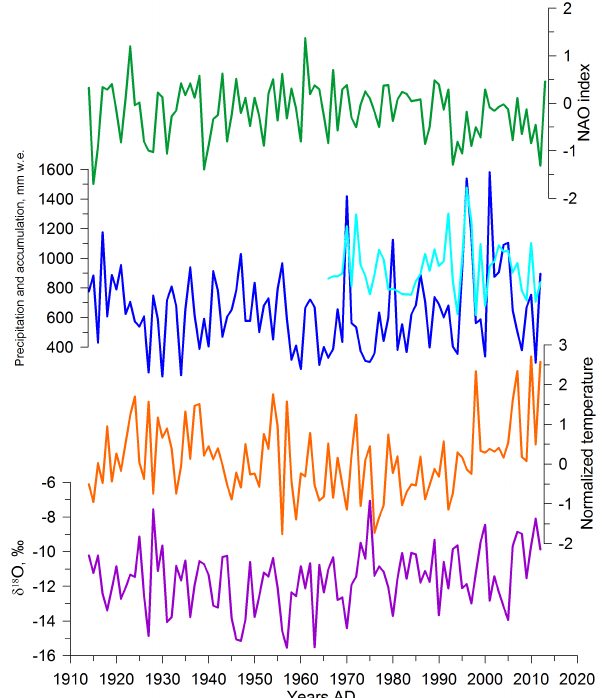
Figure 10. Same as Fig. 9 but for the warm